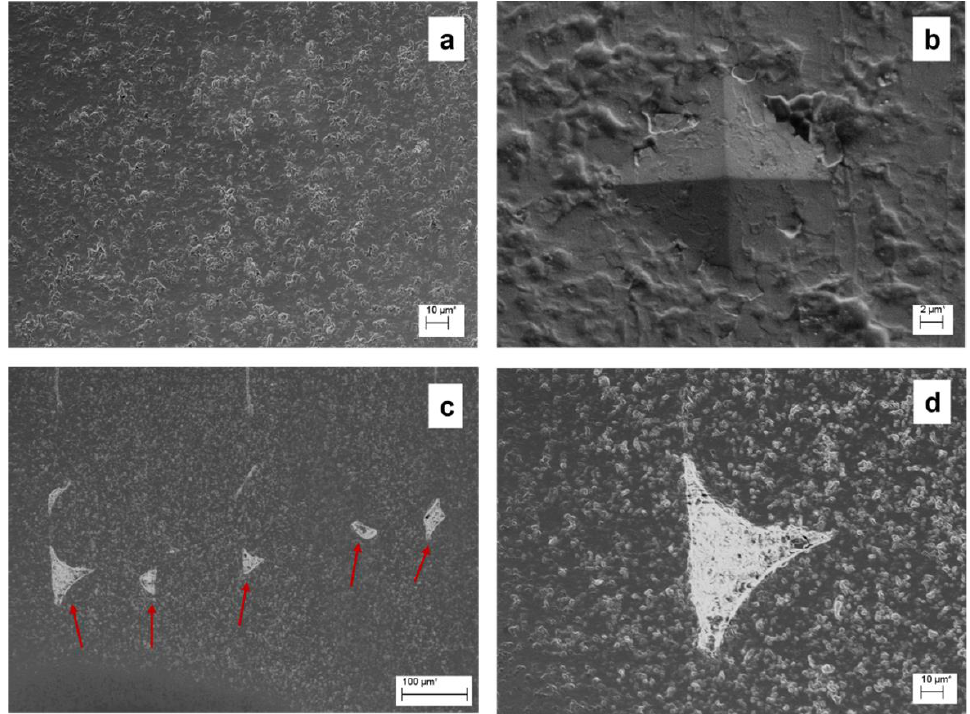
Figure 5. Morphology of sintered 3D-printed alumina sample observed by SEM. ( a ) Low magnifi- cation, ( b ) detail of Vickers hardness imprint, ( c ) porosity (arrows) as a result of the FFF process, ( d ) detail of porosity.